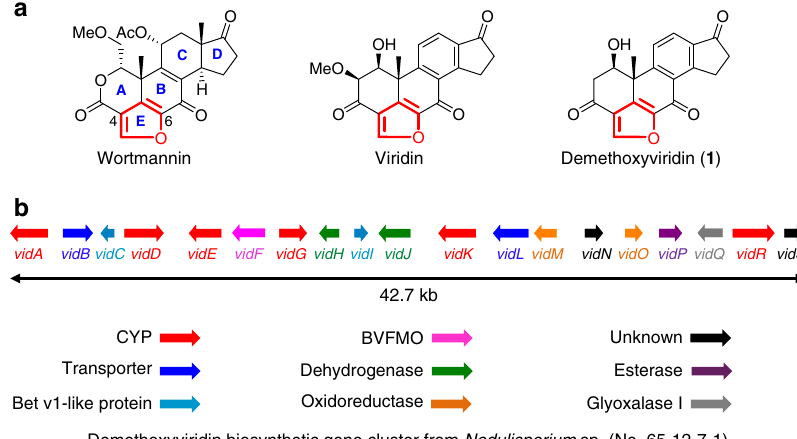
Fig. 1 Representative furanosteroids and biosynthetic gene cluster of demethoxyviridin ( 1 ). a Structures of wortmannin, viridin, and demethoxyviridin ( 1 ). b Gene map of the demethoxyviridin biosynthetic gene cluster from Nodulisporium sp. (no. 65-12-7-1), consisting of 19 genes from vidA ( g3266 ) to vidS ( g3284 ). The arrow indicates the direction from the start to the stop codon. Different types of genes are indicated by different colors and among them red arrows indicate six CYP